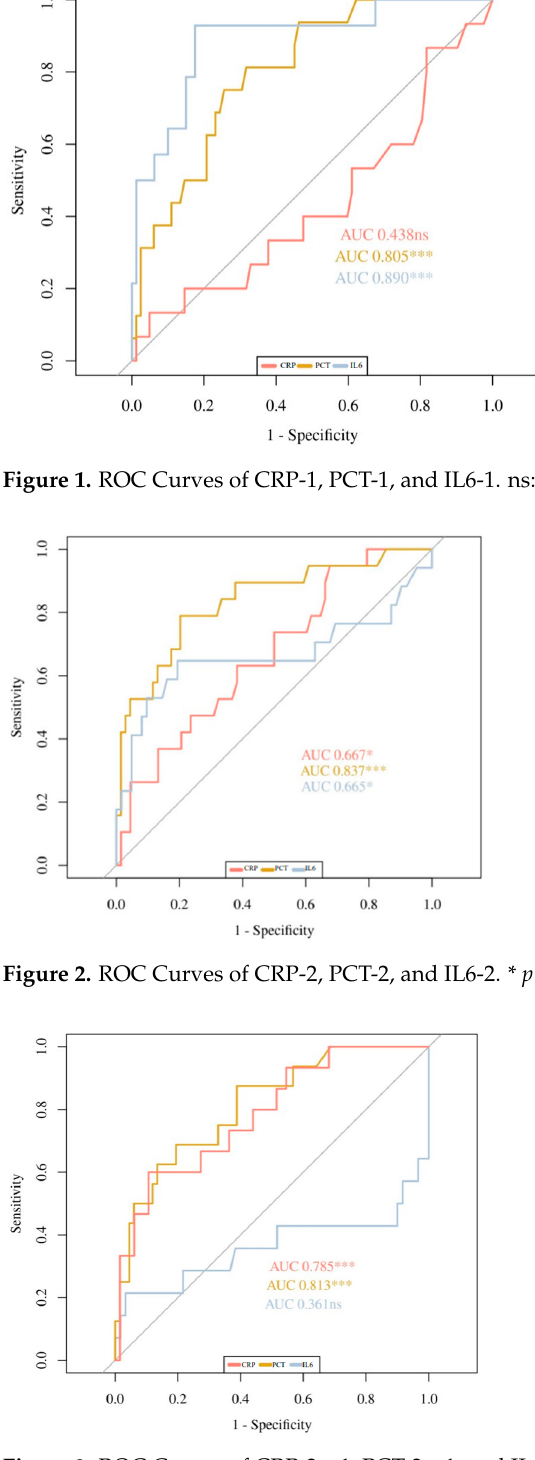
Figure 3. ROC Curves of CRP-2vs1, PCT-2vs1, and IL6-2vs1. ns: non significance. *** p < 0.001.